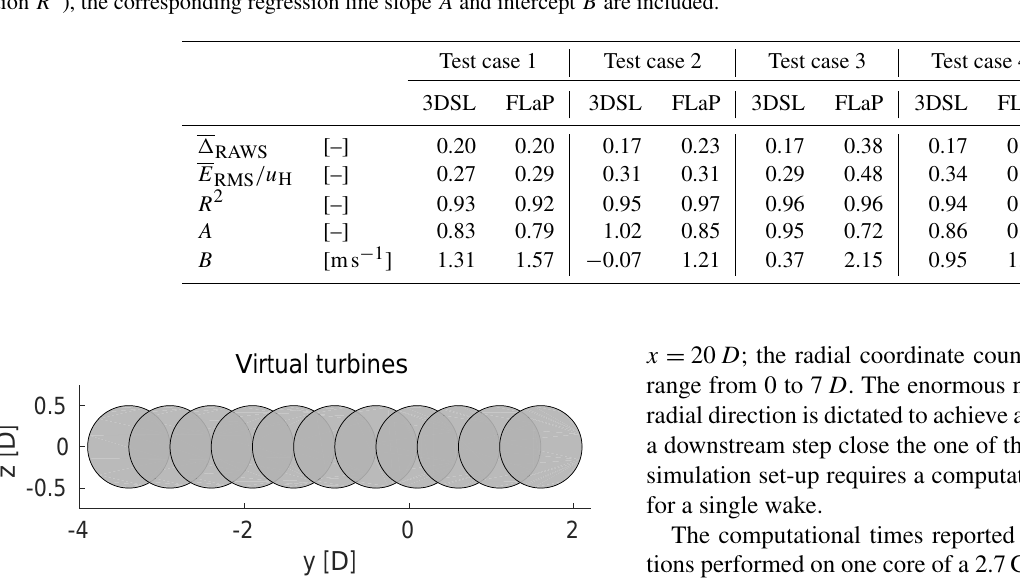
Table 1. Overall performance of the 3DSL model and FLaP (Ainslie model) in relation to the reference large-eddy simulation wind field. Namely, the average deviation (cid:49) RAWS of the rotor-average wind speed, the total root mean square error E RMS , the coefficient of determina- tion R 2 ), the corresponding regression line slope A and intercept B are included.